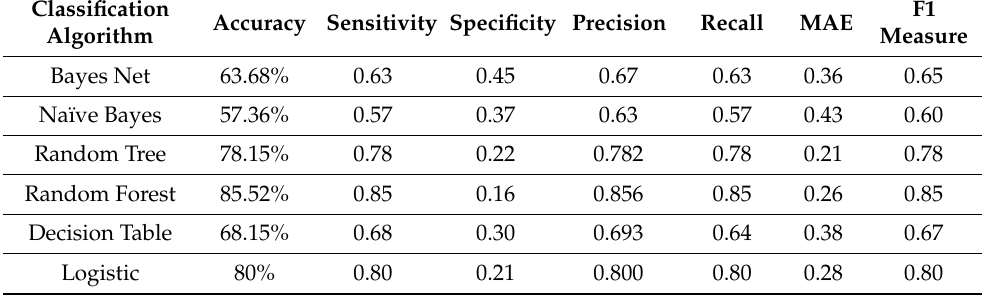
Table 10. GLRLM results on Dataset-II.